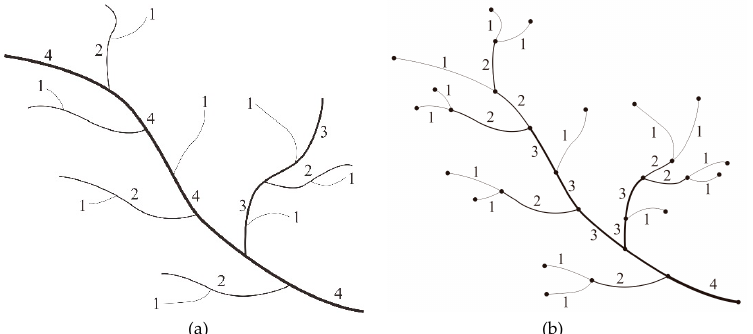
Figure 1. Two classic stream coding systems for dendritic river features: ( a ) Horton coding based on river streams and ( b ) Strahler coding based on river segments.